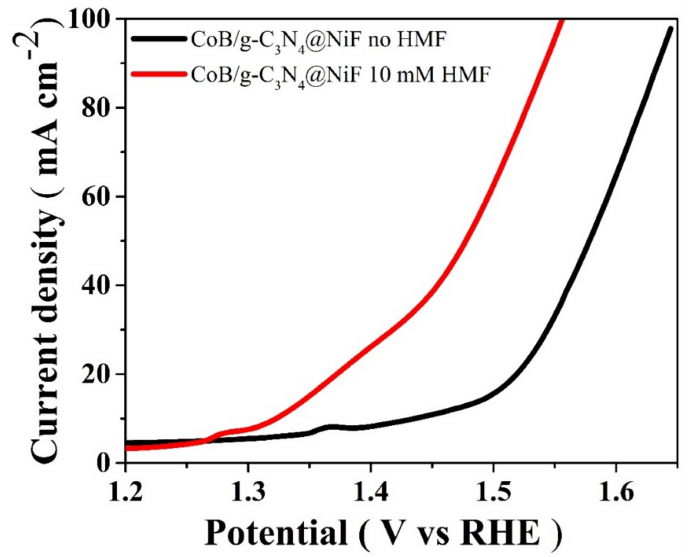
Figure 3. LSV of CoB/g-C 3 N 4 @NiF in the absence and existence of HMF in 10 mM concentration in